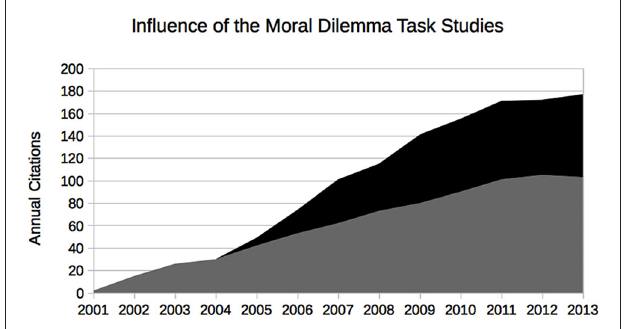
FIGURE 1 | Evidence of the communication success of the original moral neuroscience studies by Greene et al. from the ISI Web of Science . The authors were not only the first to present difficult philosophical moral dilemmas to their subjects in the brain scanner, but suggested a strong normative significance of their findings, provoking responses from other scholars. Gray: Greene et al. (2001) (overall 782 citations); black: Greene et al. (2004) (overall 446